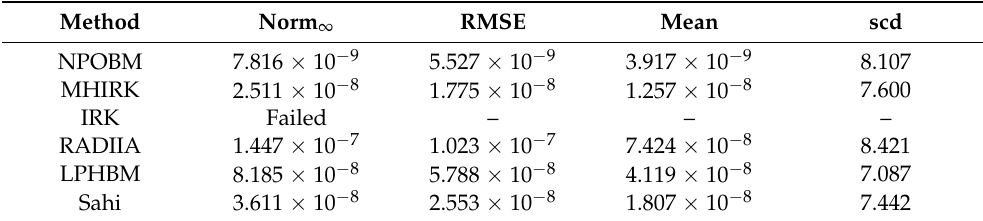
Table 17. Numerical results for Problem 5 with NS = 2 6 where x ∈ [ 0,20 ] .